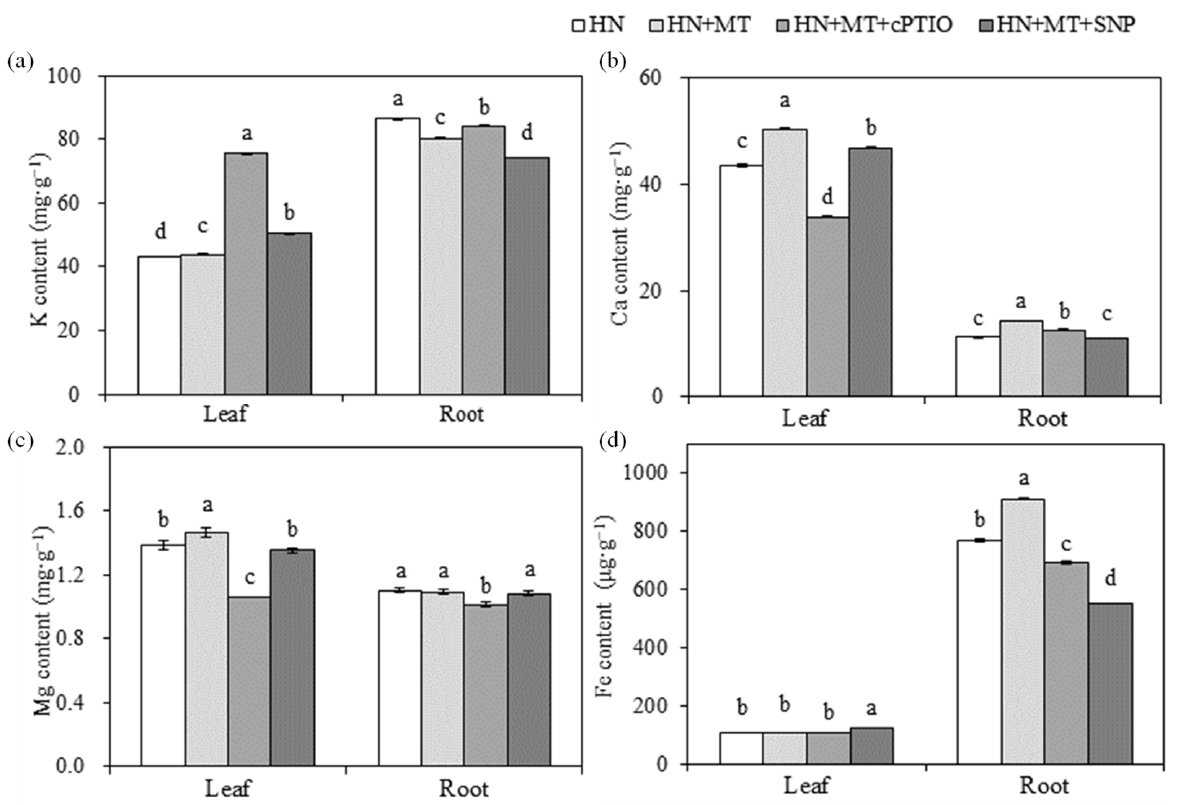
Figure 5. Effects of MT and NO on accumulation of mineral elements of cucumber seedlings under nitrate stress. ( a ) Potassium (K). ( b ) Calcium (Ca). ( c ) Magnesium (Mg). ( d ) Iron (Fe). Error bars represent standard deviations of the means of three independent replicates. Different letters indicate significant differences between treatments by Duncan’s multiple range test ( p < 0.05).